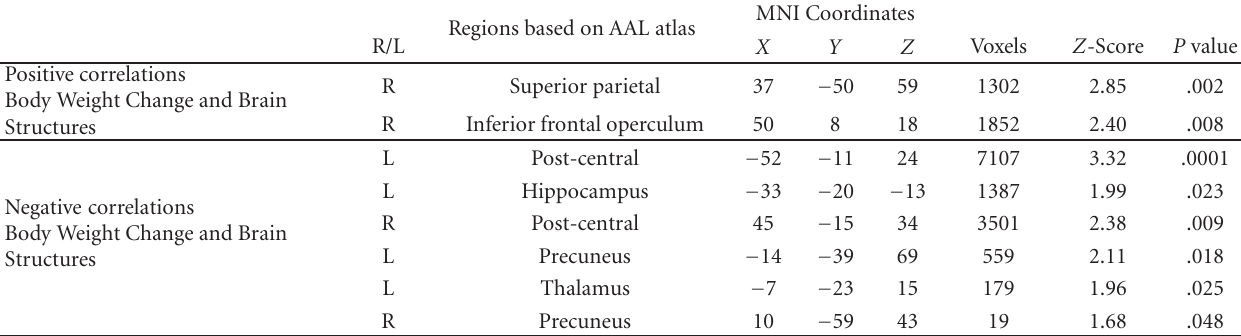
Table 2: Correlations between grey matter volumes after olanzapine treatment and body weight changes observed in schizophrenia patients.